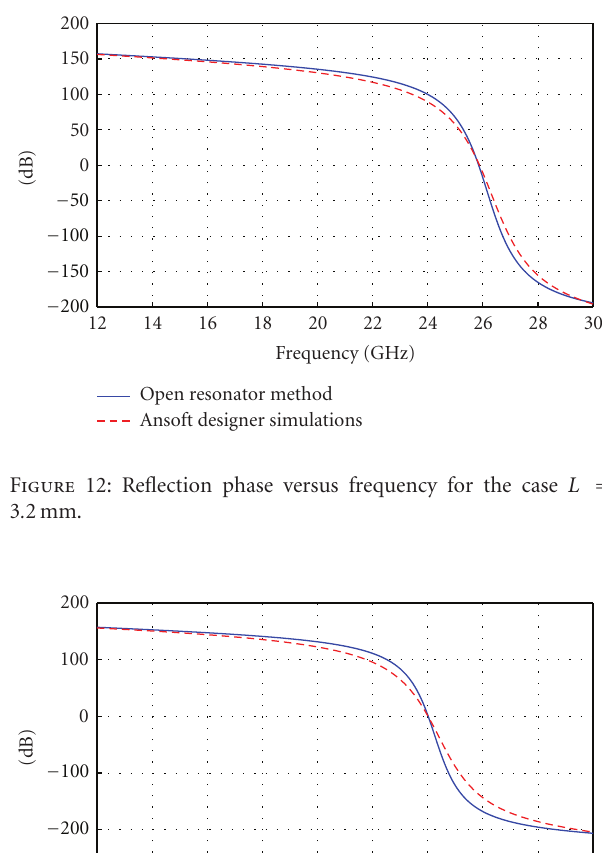
Figure 11: Measured return loss for the case L = 3 . 7mm.